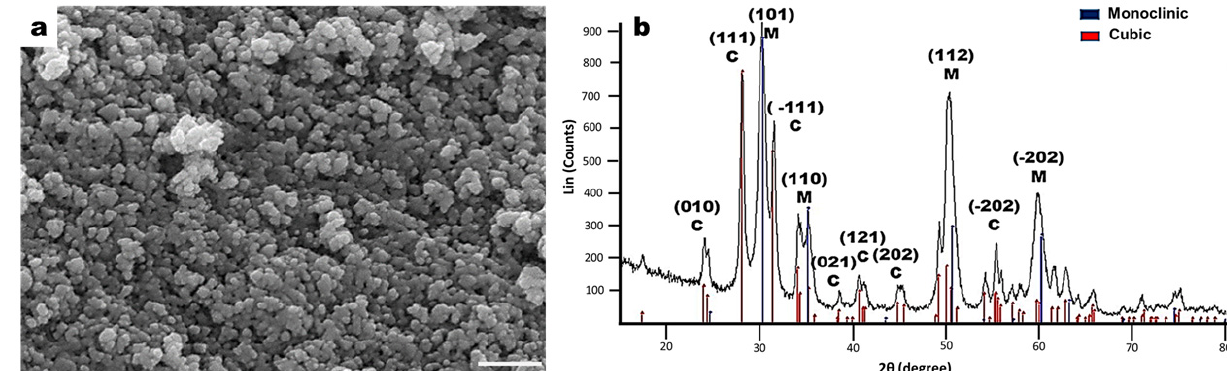
Figure 1. Characterization of zirconium oxide (ZrO 2 ) nanoceramic. ( a ) Scanning electron microscopy images of zirconium oxide nanoparticles. ZrO 2 nanoparticles with homogeneous morphology and semispherical surface; the nanoparticles tend to agglomerate; scale bar = 200 nm. ( b ) X-ray diffraction patterns of ZrO 2 nanoparticles obtained with incident angles at 30.5°, 31.7°, 35.2°, 50.2°, 60.1°, and 63.2°.